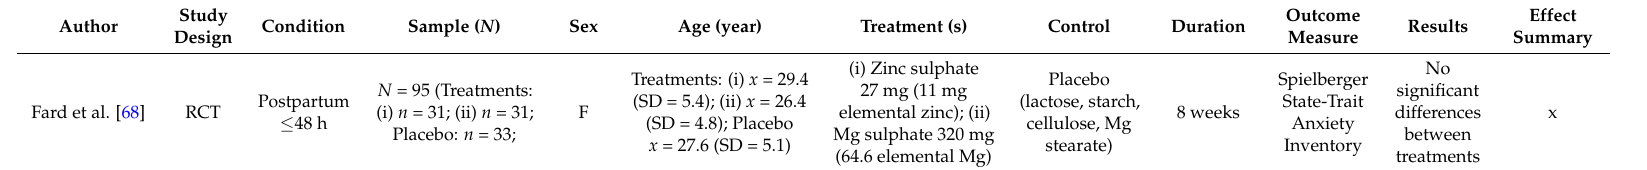
Table 3. Summary of studies reporting the effects of Mg on subjective anxiety/stress in postpartum women.